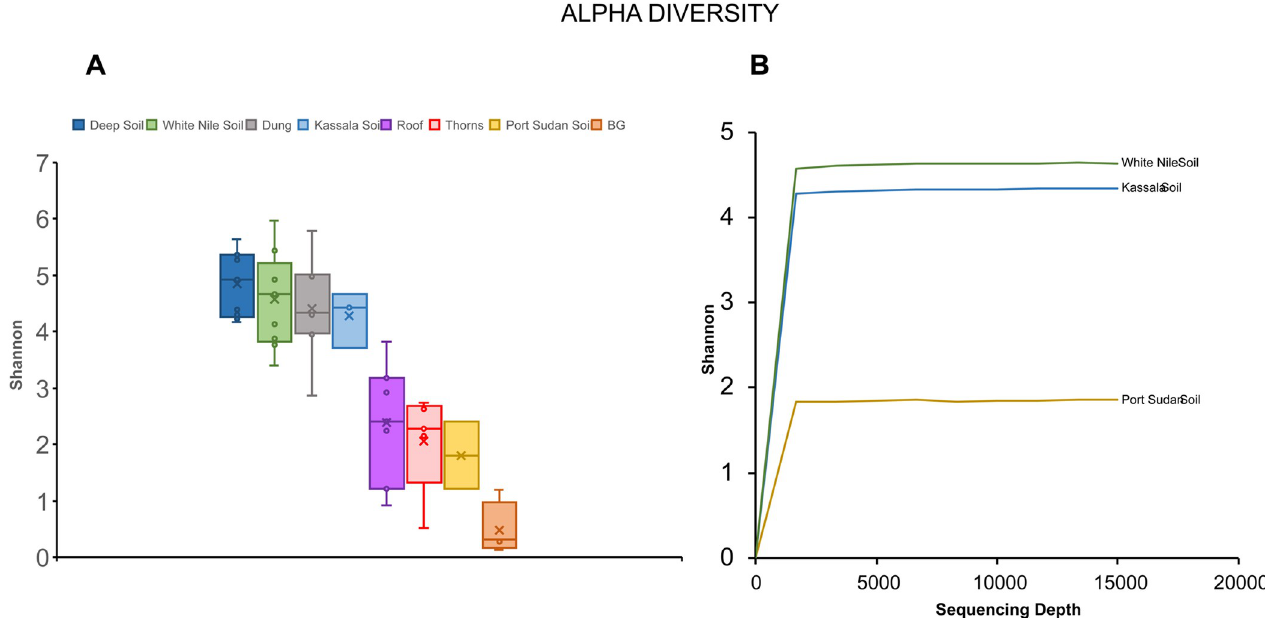
Fig 2. Alpha diversity calculated as Shannon index of the samples grouped for type (a): superficial and deep soil, control soil, walls, dung, roof, thorns and black grains and rarefaction curves of endemic and non-endemic samples (b): White Nile Soil is endemic whereas Kassala and Port Sudan is non-endemic. https://doi.org/10.1371/journal.pntd.0010385.g002 M . mycetomatis represented 10% of all eumycetoma-associated sequences (0.7% of total sequences) across all endemic samples within the study. This places it at the third most abun- dant eumycetoma-associated species following Exserohilum rostratum ( E . rostratum ) (28%) and Alternaria alternata ( A . alternata ) (14%). Interestingly, of the above three species only A . alternata was found to grow in culture (2%). M . mycetomatis was found in all houses, ranging from 0.2% to 6.3% of total sequences (Sheets B-D in S1 Table). No significant difference was